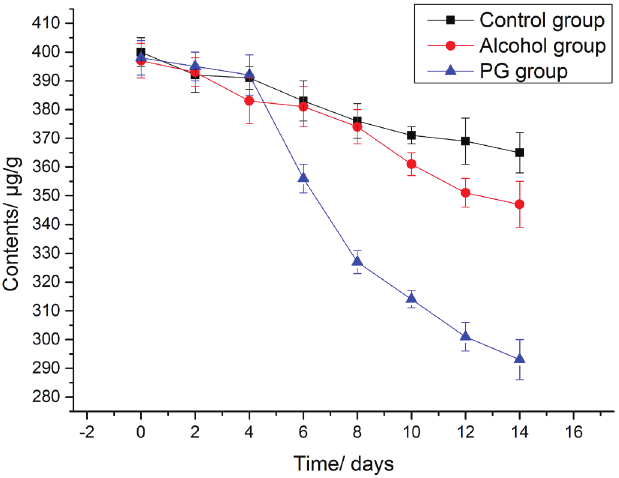
FIGURE 6 - Effect of PG on the contents of free